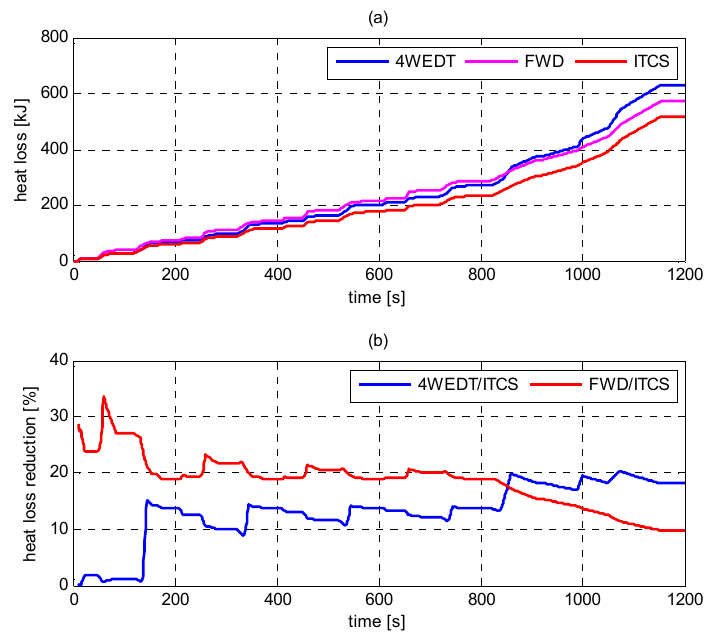
Figure 7. Heat loss and its reduction rate: ( a ) heat loss of different allocation approaches; and ( b ) heat loss reduction.